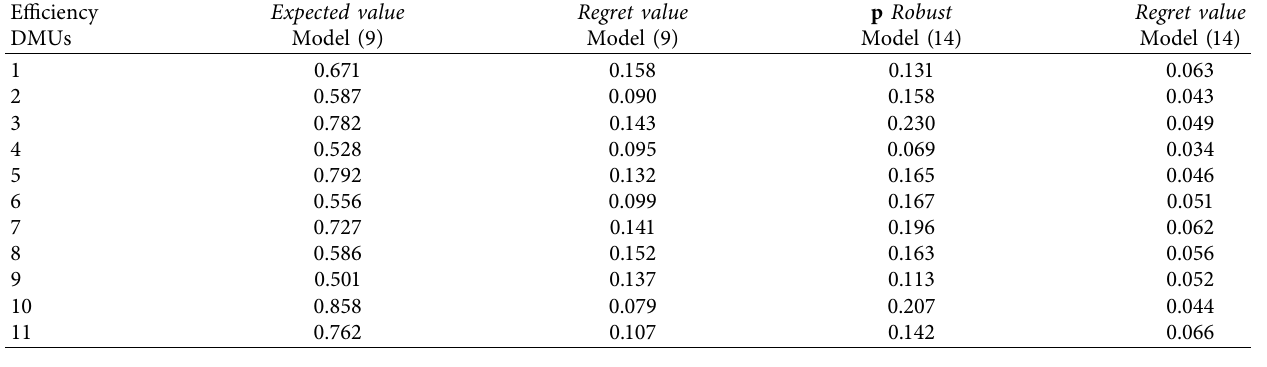
Table 11: The results of expected and regret values of models (9) and (14)in two scenarios.